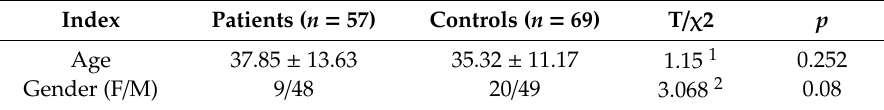
Table 1. The demographic information of schizophrenia patients and healthy